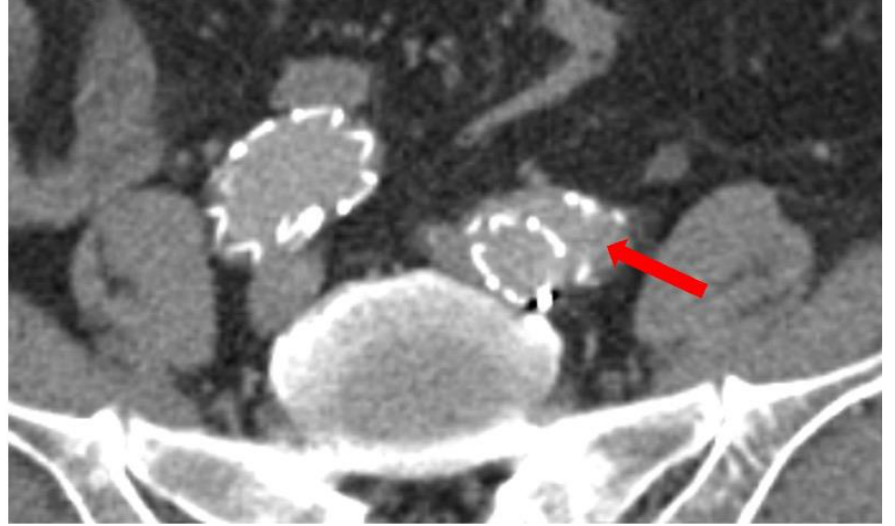
Figure 2. Example of an iliac detachment of the stent graft to the vessel wall at distal landing zone. Arrow pointing to the detachment with contrast medium and space between the iliac limb and the vessel wall.